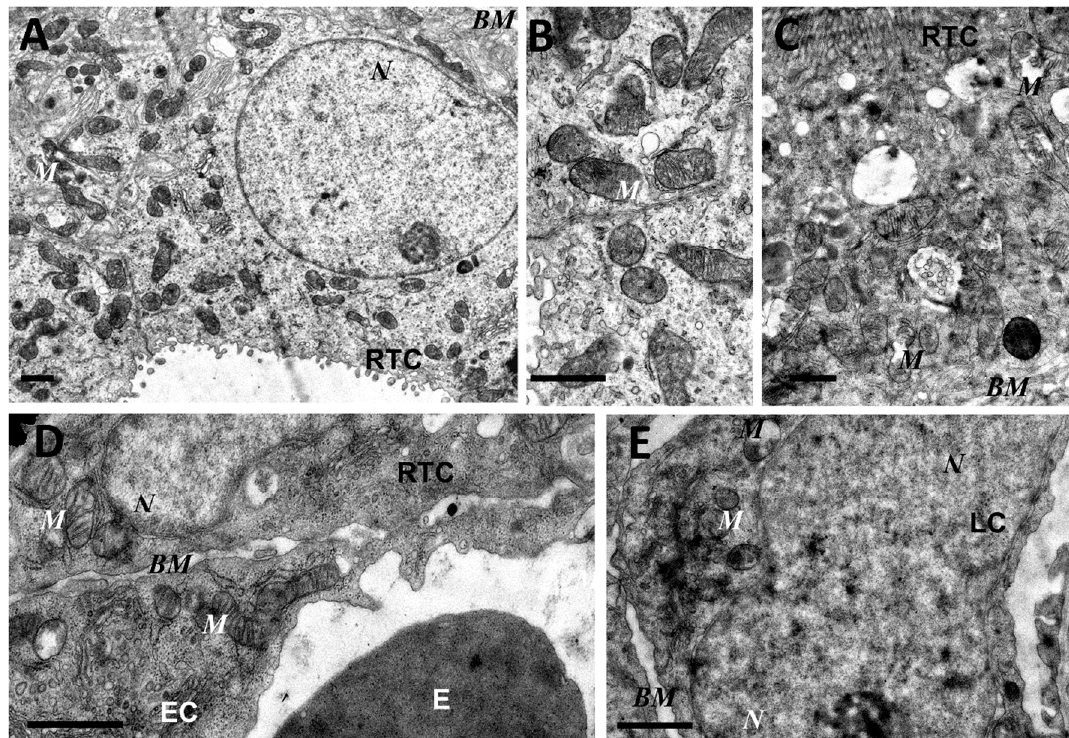
Figure 3. Partial restoration of mitochondrial ultrastructure of renal tubular cells ( A–C ), endothelium ( D ), and leukocytes ( E ) after LPS administration with plastoquinol decylrhodamine (SkQR1) treatment. Renal tubular cells (RTC), endothelial cells (EC), and leukocytes (LC) contain a major portion of normal mitochondria (M) in orthodox configuration and few swollen mitochondria (C). BM, basal membrane; N, nucleus; E, erythrocyte in the vessel. Scale bar, 1 μ m.